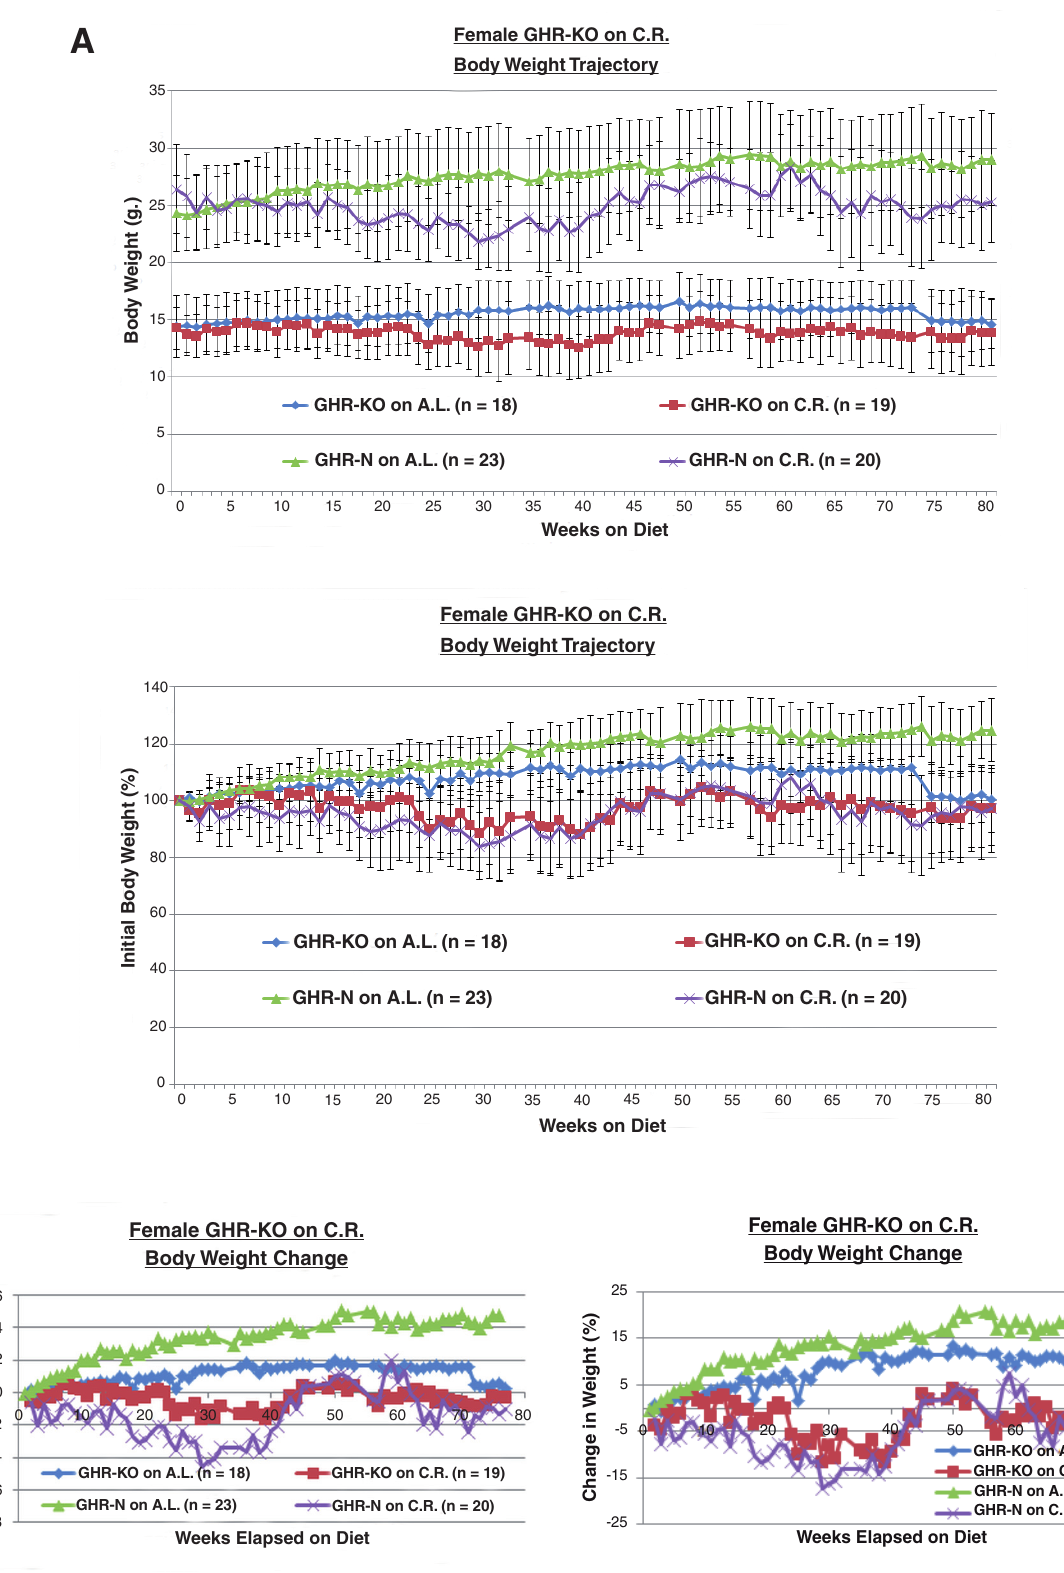
Figure 1. Effects of genotype and diet on body weight. A. 30% caloric restriction represses body weight gain (absolute or normalized-to- initial) in female GHR-KO mice and their littermate controls. B. 30% caloric restriction reins change in body weight (absolute or normalized-to- initial) in GHR-KO females and their littermate